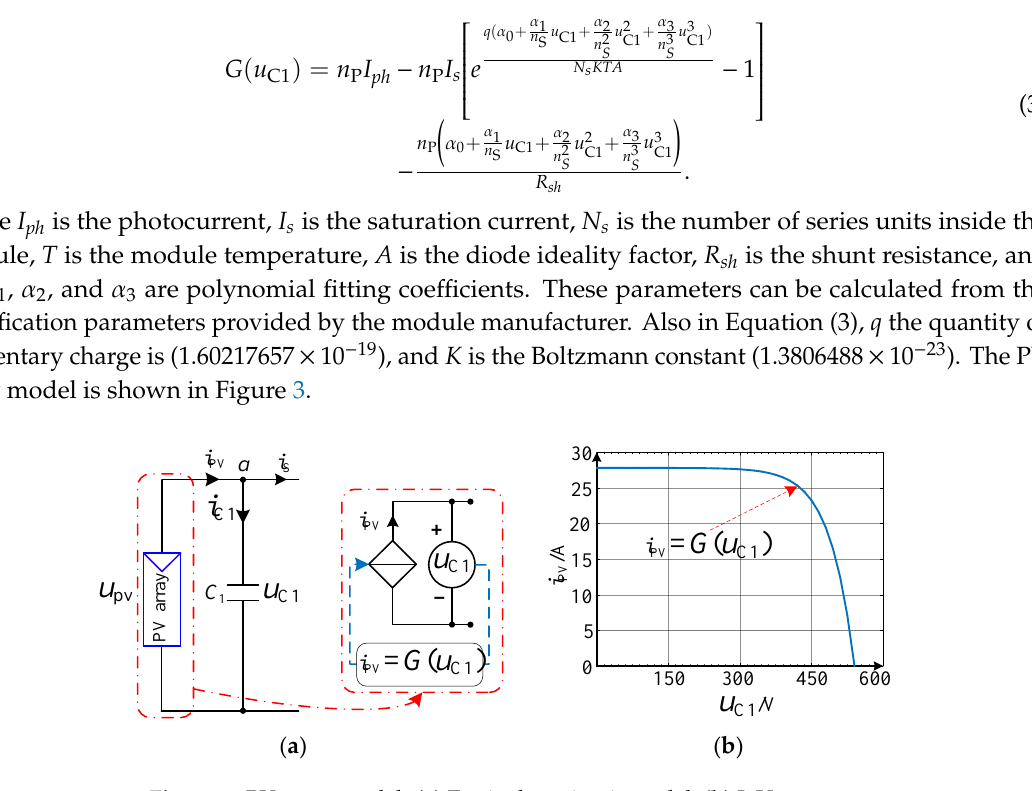
Figure 3. PV array model. ( a ) Equivalent circuit model; ( b ) I–U